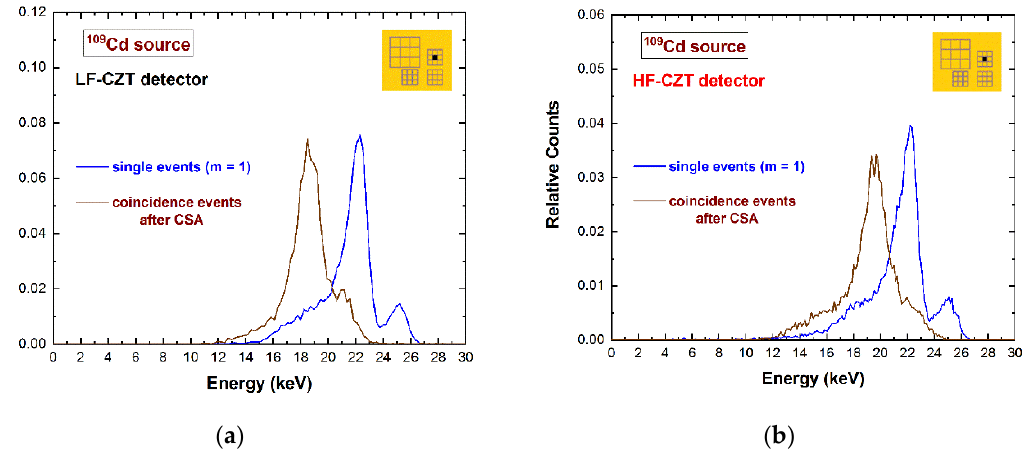
Figure 6. Measured 109 Cd energy spectra with single events (blue line) and coincidence events (multiplicity m = 2) after CSA (brown line) for the ( a ) LF-CZT and ( b ) HF-CZT detectors. The energy deficits due to charge losses near the inter-pixel gaps are more severe for the LF-CZT detector. The energy deficits of the 22.1 keV photopeaks after CSA are approximately 3.5 keV